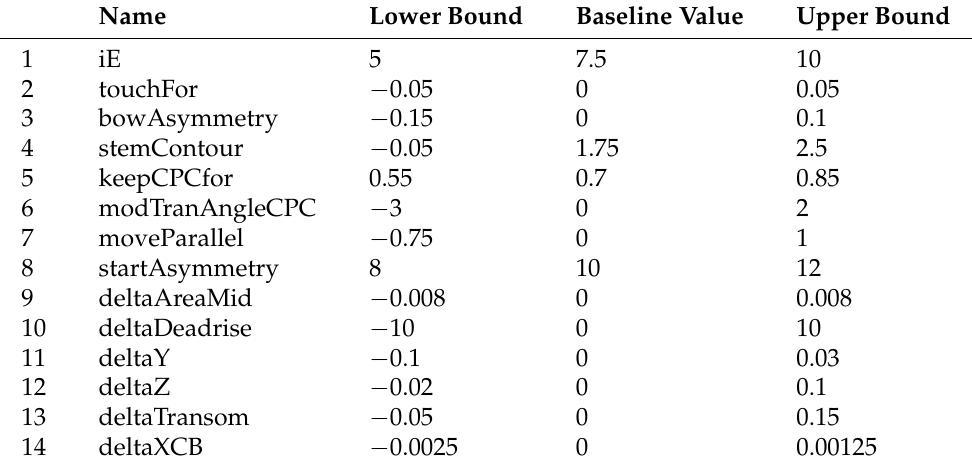
Table 3. Bounds of design variables used for optimisation (CAD space).